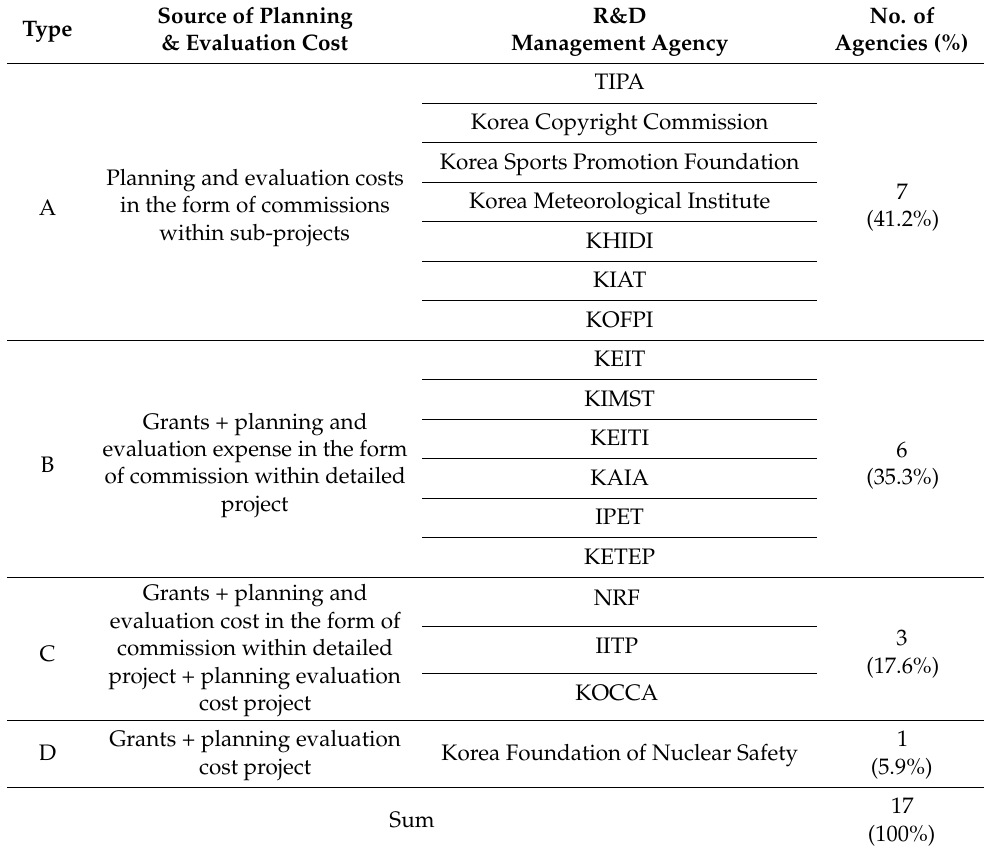
Table 3. Classification by Income type of planning and evaluation costs